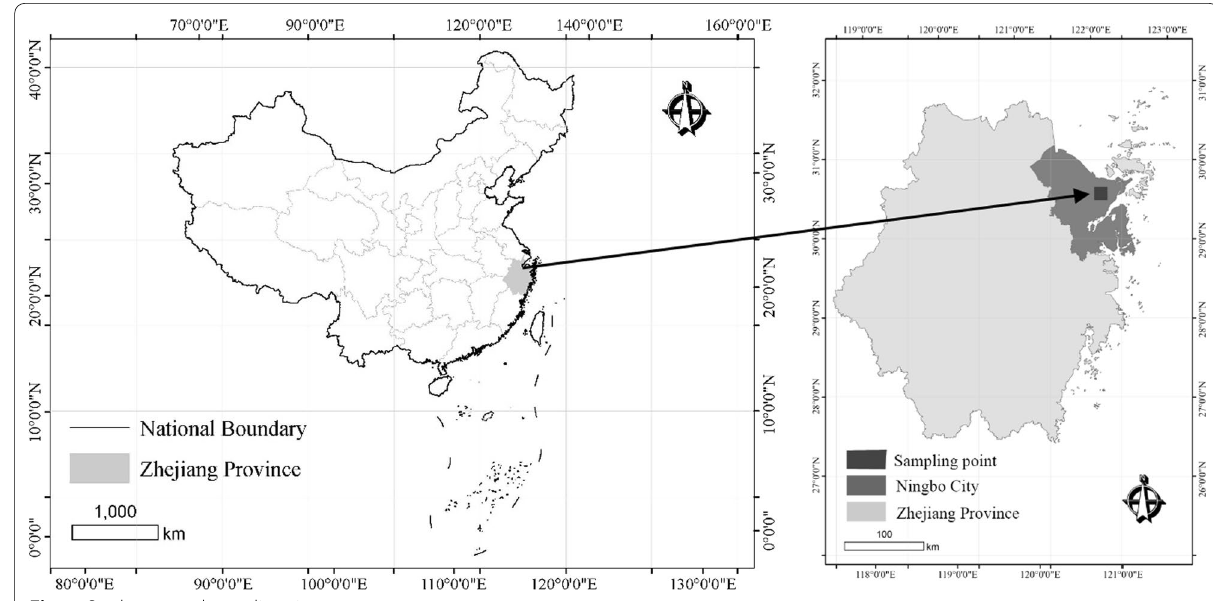
Fig. 1 Study area and sampling